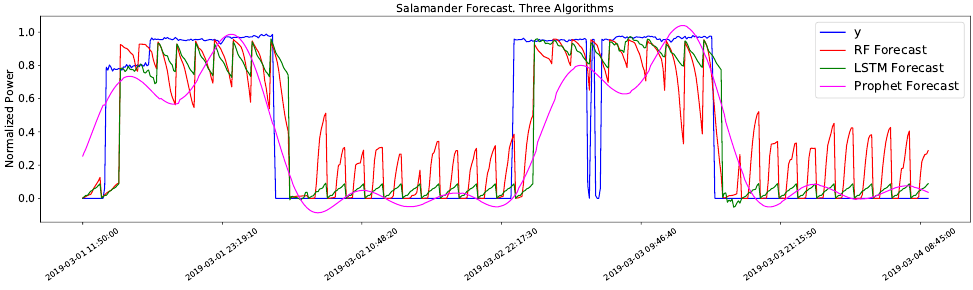
Figure 2. Results of the salamander forecast with three algorithms against the measured data (Y).